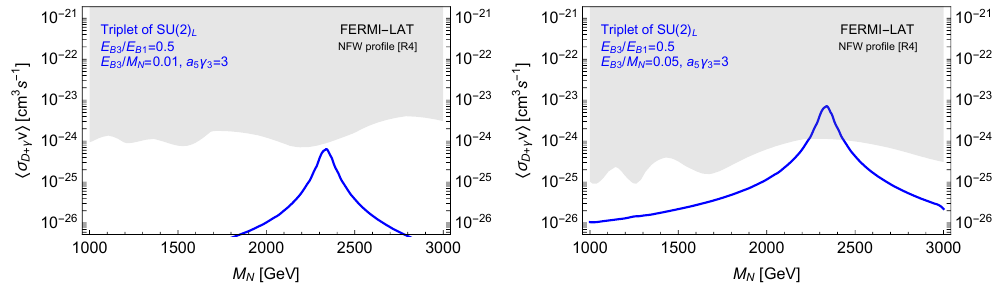
through magnetic 3